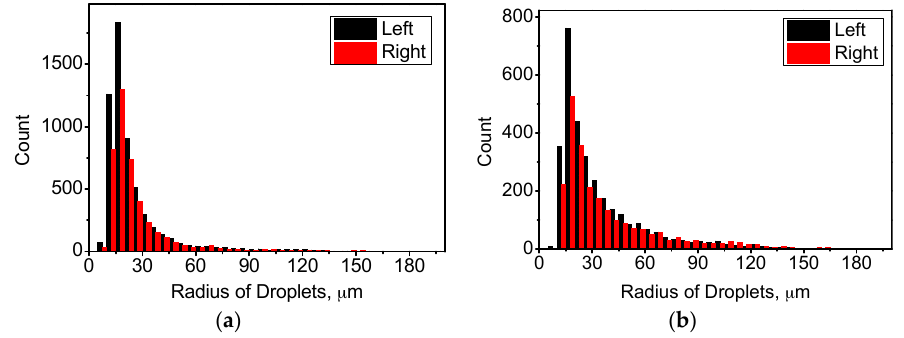
Figure 7. Comparison of radius distribution between left part and right part in case of ( a ) 0 T and ( b ) 12 T. ( a ) 0 T, 0.2 s; ( b ) 12 T, 2 s.